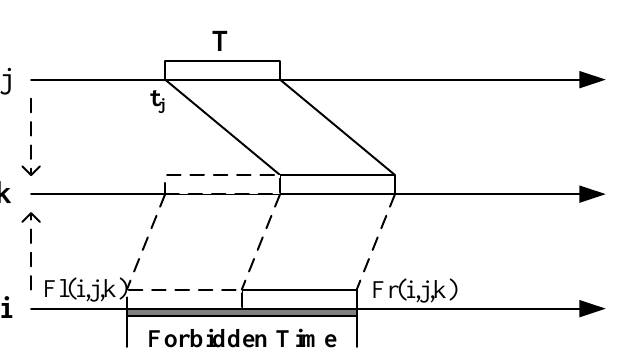
Figure 3. Calculation of forbidden